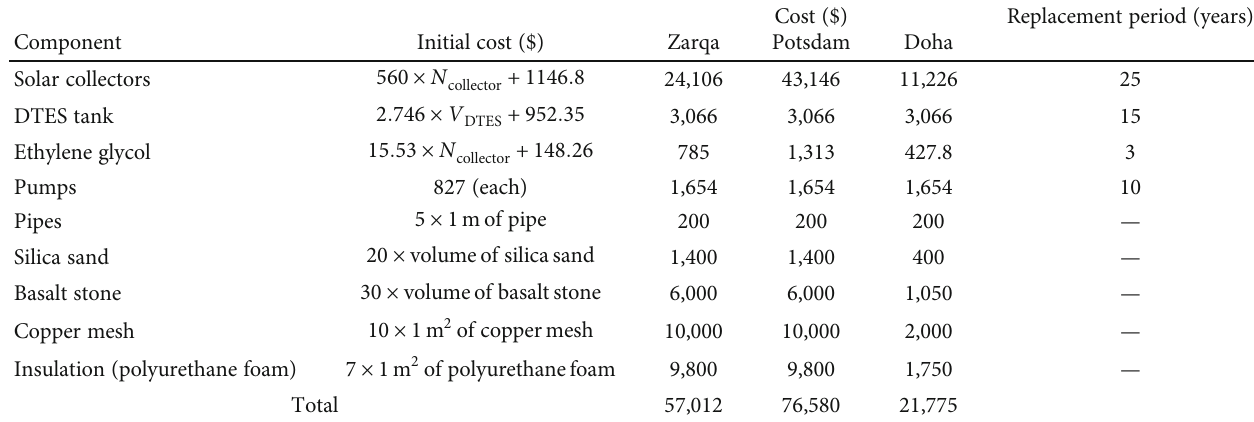
Table 7: The capital cost of solar combisystem and STES [50].